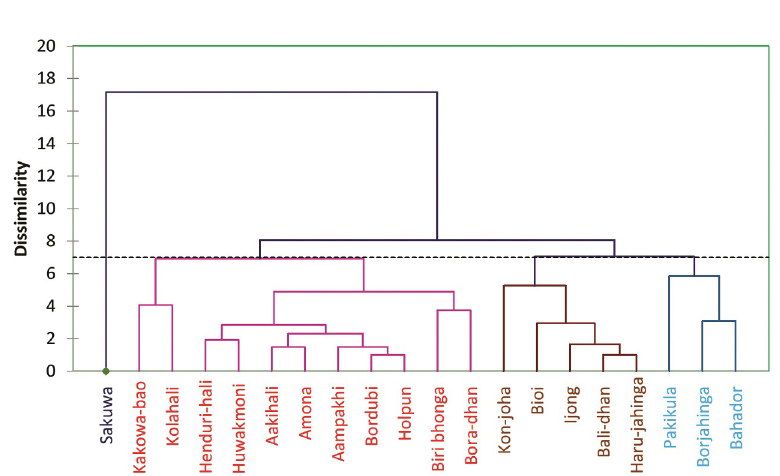
Fig. 2. Dendogram showing variation among the rice landraces based on grains morphological traits. The clusters are displayed with four different